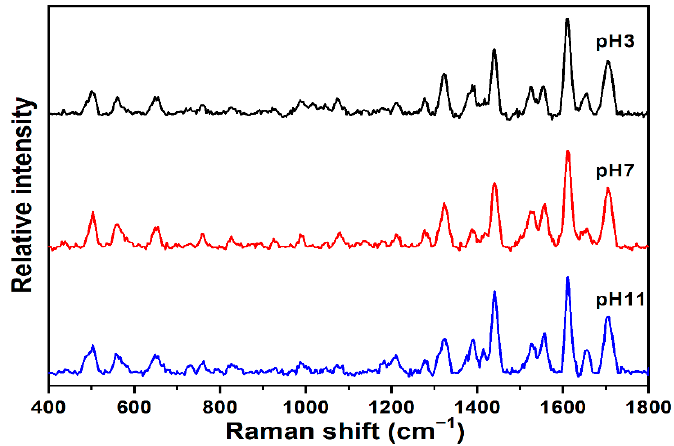
Figure 4. SERS of 1 ppm caffeine in water on SERS-active gold sol–gel capillaries at pH = 3, 7, and 11; all other spectral conditions for SERS are the same as those in Figure 2. Note, caffeine pKa = 10.4.